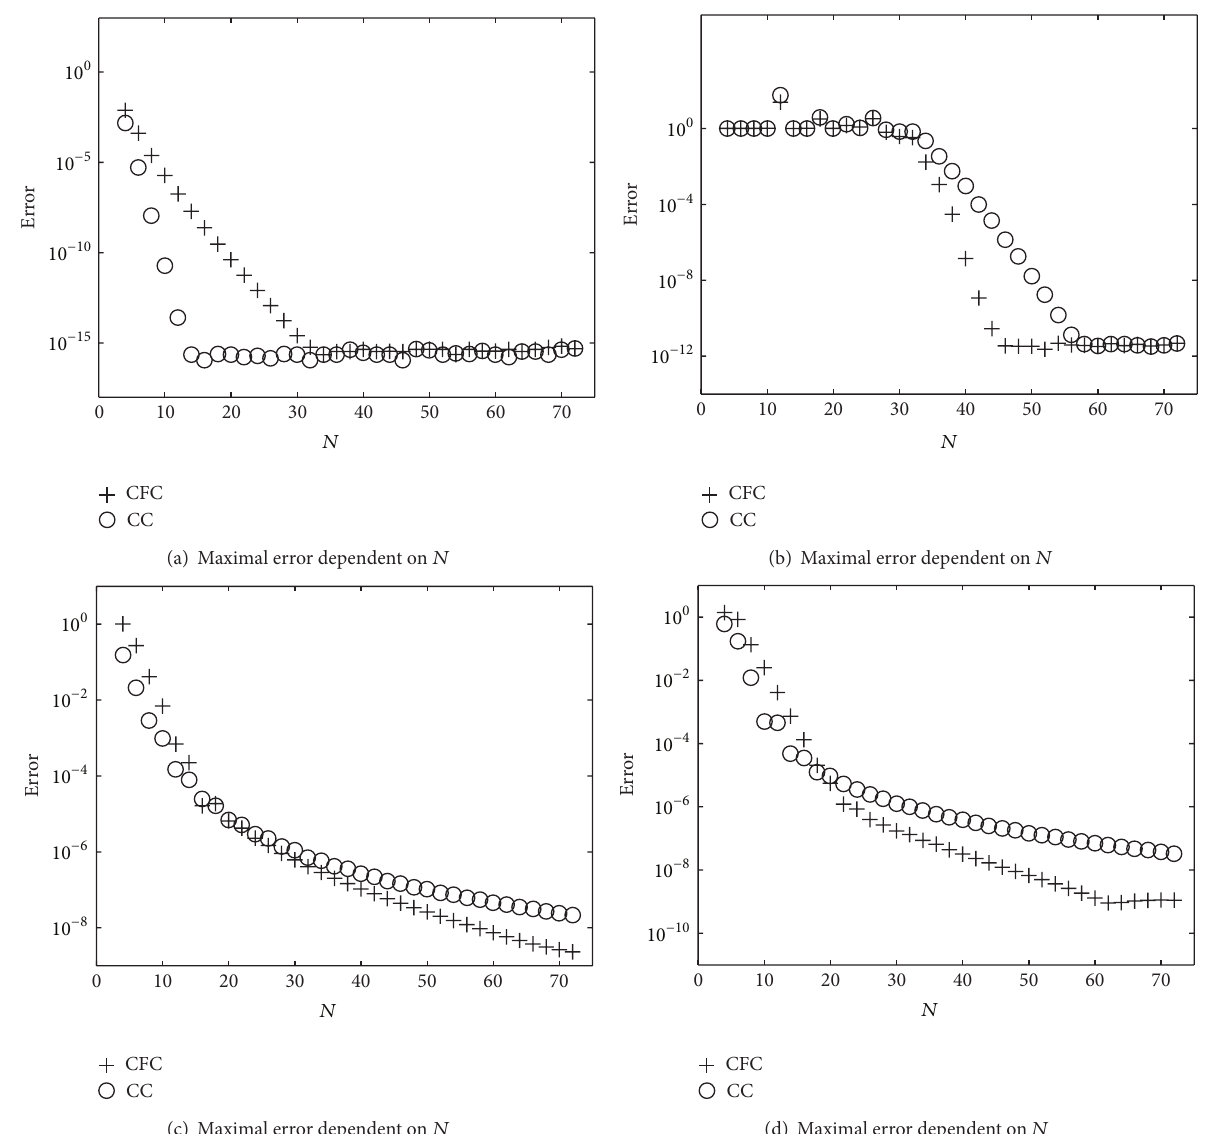
Figure 1: Plots of the maximal absolute error of the numerical solution with respect to the truncation number 𝑁 . Error of the Chebyshev- Fourier-collocation (CFC) method is shown with a plus (+) mark; error of the Chebyshev-collocation (CC) method is shown with a circle ( ∘ ) mark. (a) Error for Example 1. (b) Error for Example 2. (c) Error for Example 3. (d) Error for Example